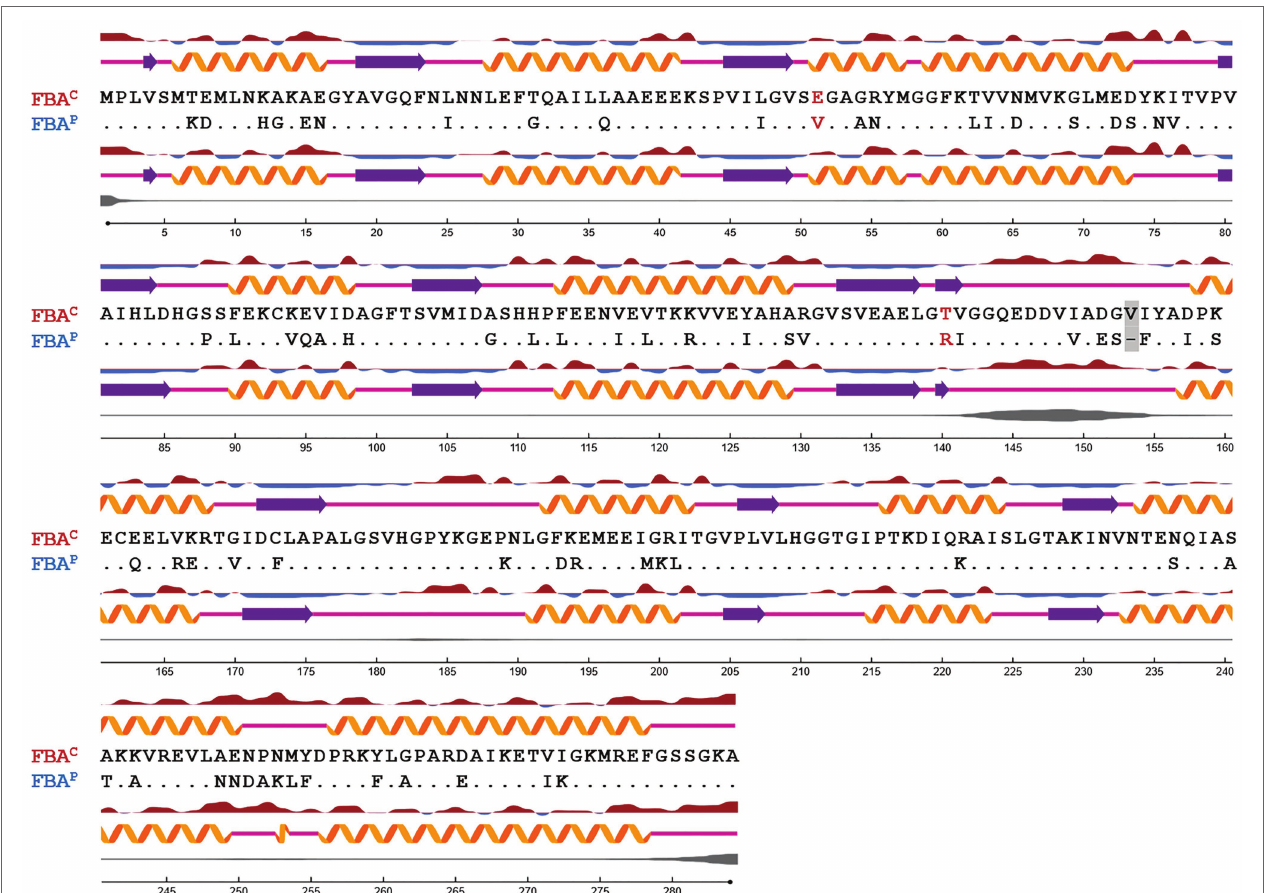
FIGURE 1 | Sequence alignment based on the secondary structure of FBA P and FBA C from B. methanolicus . Protein secondary structure and surface accessibility predictions were performed with NetSurfP (Petersen et al., 2009; Klausen et al., 2019). The secondary structure is depicted with orange α -helices, purple β -strands, or coils with pink lines, respectively. Protein surface accessibility is shown by red (exposed) or blue (buried) waves, thresholder at 25%. Dots are representing identical amino acids. Amino acid residues exchanged by SDM are highlighted in red. A gray box depicts a gap in the amino acid sequence of FBA P in comparison to FBA C